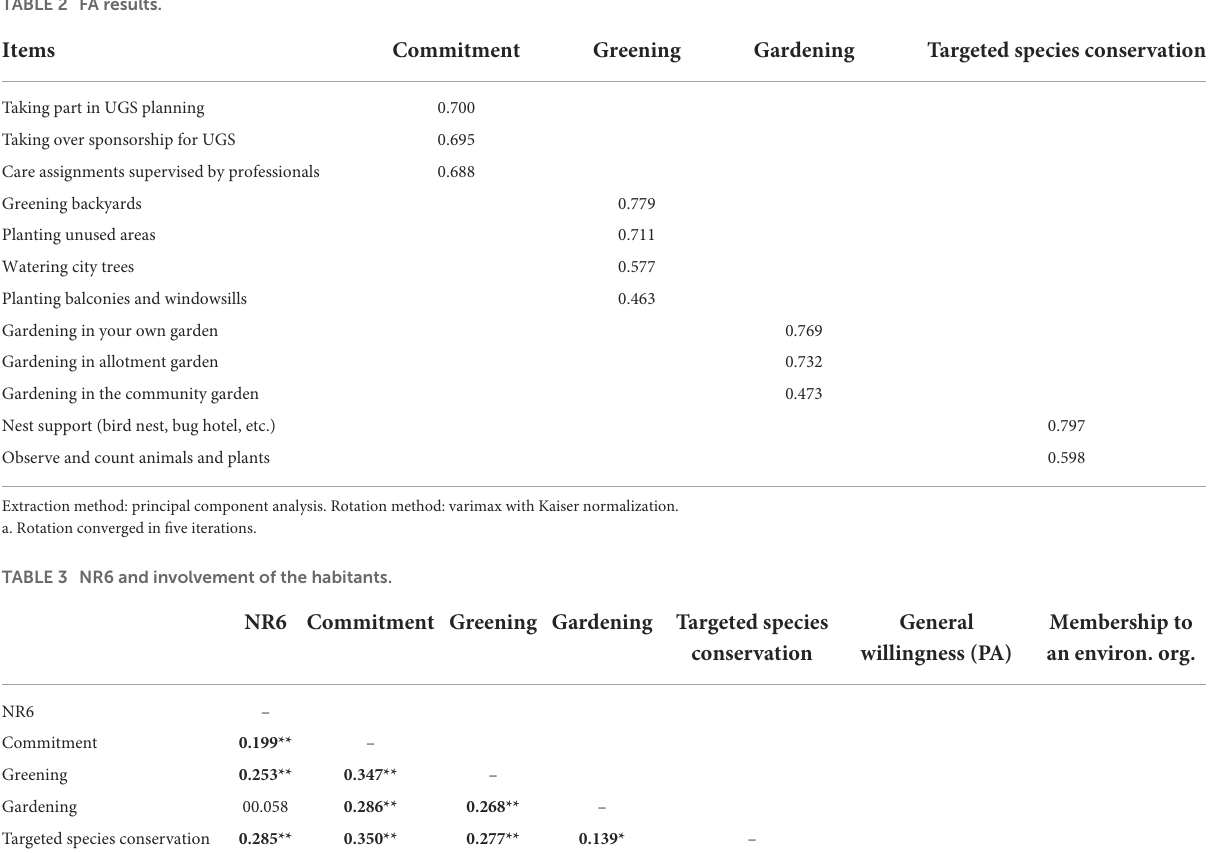
TABLE 2 FA results.